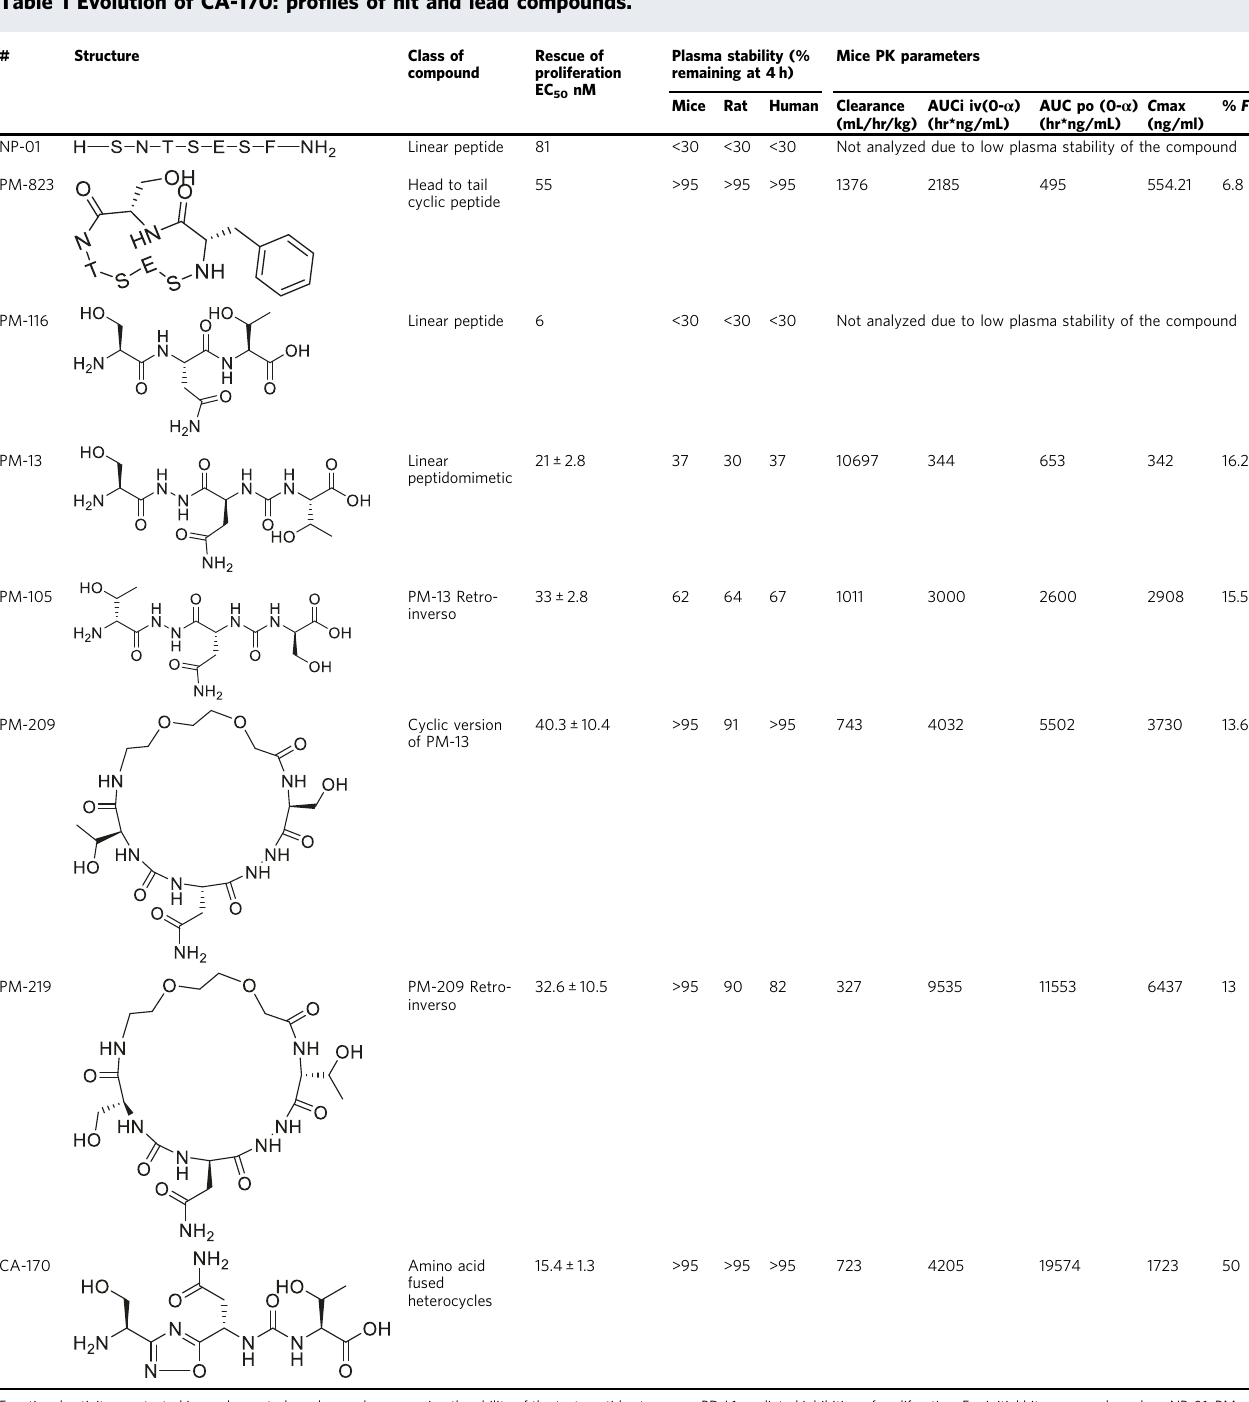
Functional activity was tested in a splenocyte-based assay by measuring the ability of the test peptides to rescue PD-L1 mediated inhibition of proliferation. For initial hit compounds such as NP-01, PM- 823, and PM-116 data is presented as EC 50 value for rescue of proliferation from a set of triplicate values ( n = 1). For all lead compounds PM-13, PM-105, PM-209, PM-219, and CA-170 data is represented as mean±S.D of two independent studies. Mice, rat, and human plasma stability values were represented as mean of duplicate of percent parent compound remaining at 4h, tested at 10 μ M. Mice PK parameters including oral bioavailability were determined from intravenous and oral route of administration of compounds at 1mgkg − 1 and 30mgkg − 1 ,